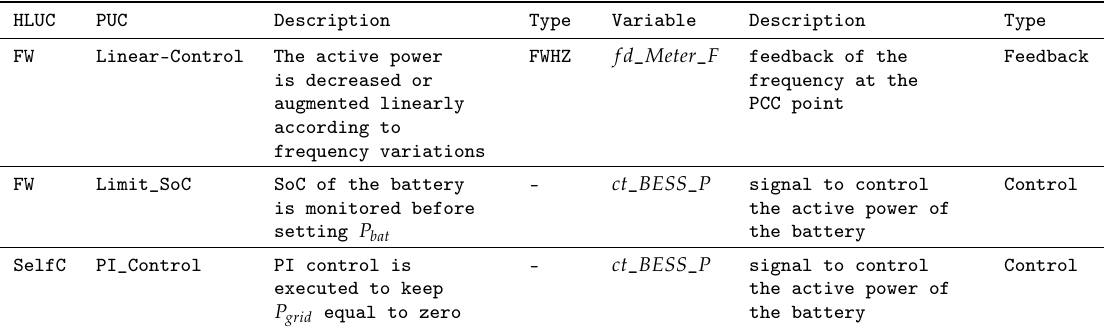
Table 11. Description of PUCs within HLUC (FW, SelfC).